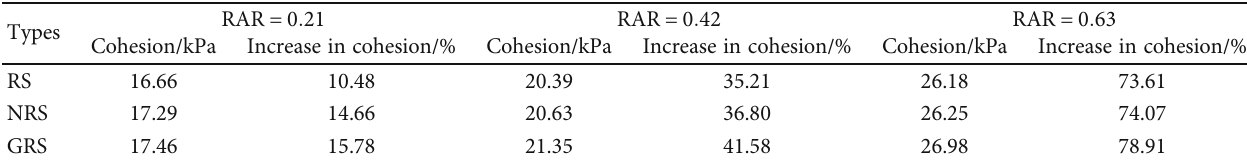
Figure 10: Stress and displacement curves of samples. Table 4: Cohesion and growth range of sample.